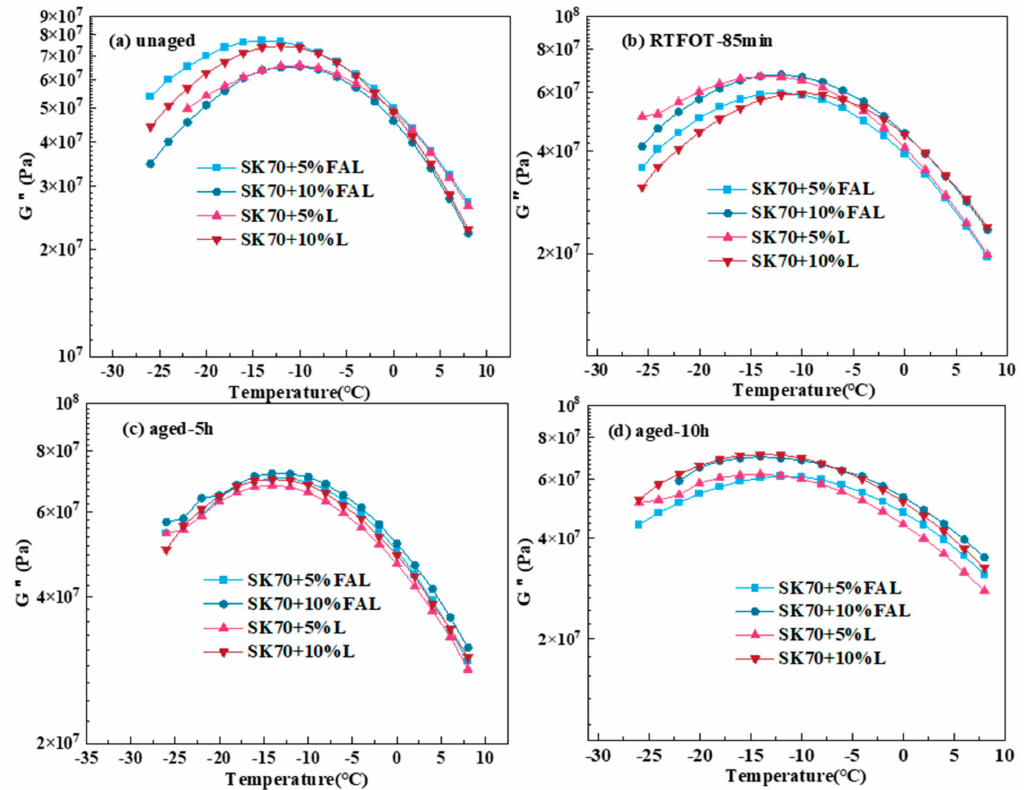
Figure 11. Curve of loss modulus G” with temperatures for each asphalt specimen at different